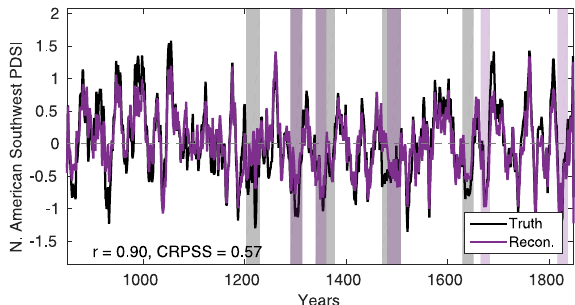
Figure 6. North American Southwest area-averaged JJA PDSI in the reconstruction mean (purple) and the climate model truth (black). Both time series have been smoothed with an 11-year mov- ing average (Meehl and Hu, 2006). The skill metrics of correlation ( r ) and the mean continuous ranked probability skill score (CRPSS) for the smoothed time series are shown in the lower left corner. The five most severe multiyear droughts over this period are highlighted in corresponding colors. Reconstruction error estimates, similar to those shown in Fig. 8, have been left off to clearly show the severe drought